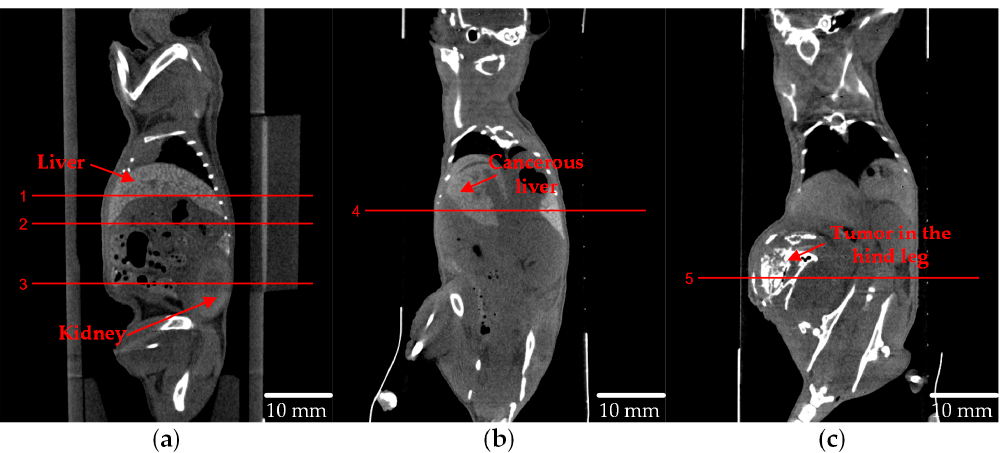
Figure 4. The sagittal plane of ( a ) the healthy mouse, ( b ) the mouse with a tumor transplanted at the liver and ( c ) the mouse with a tumor transplanted on the left leg. The red lines denote the axial slices that was chosen to perform XFCT imaging.